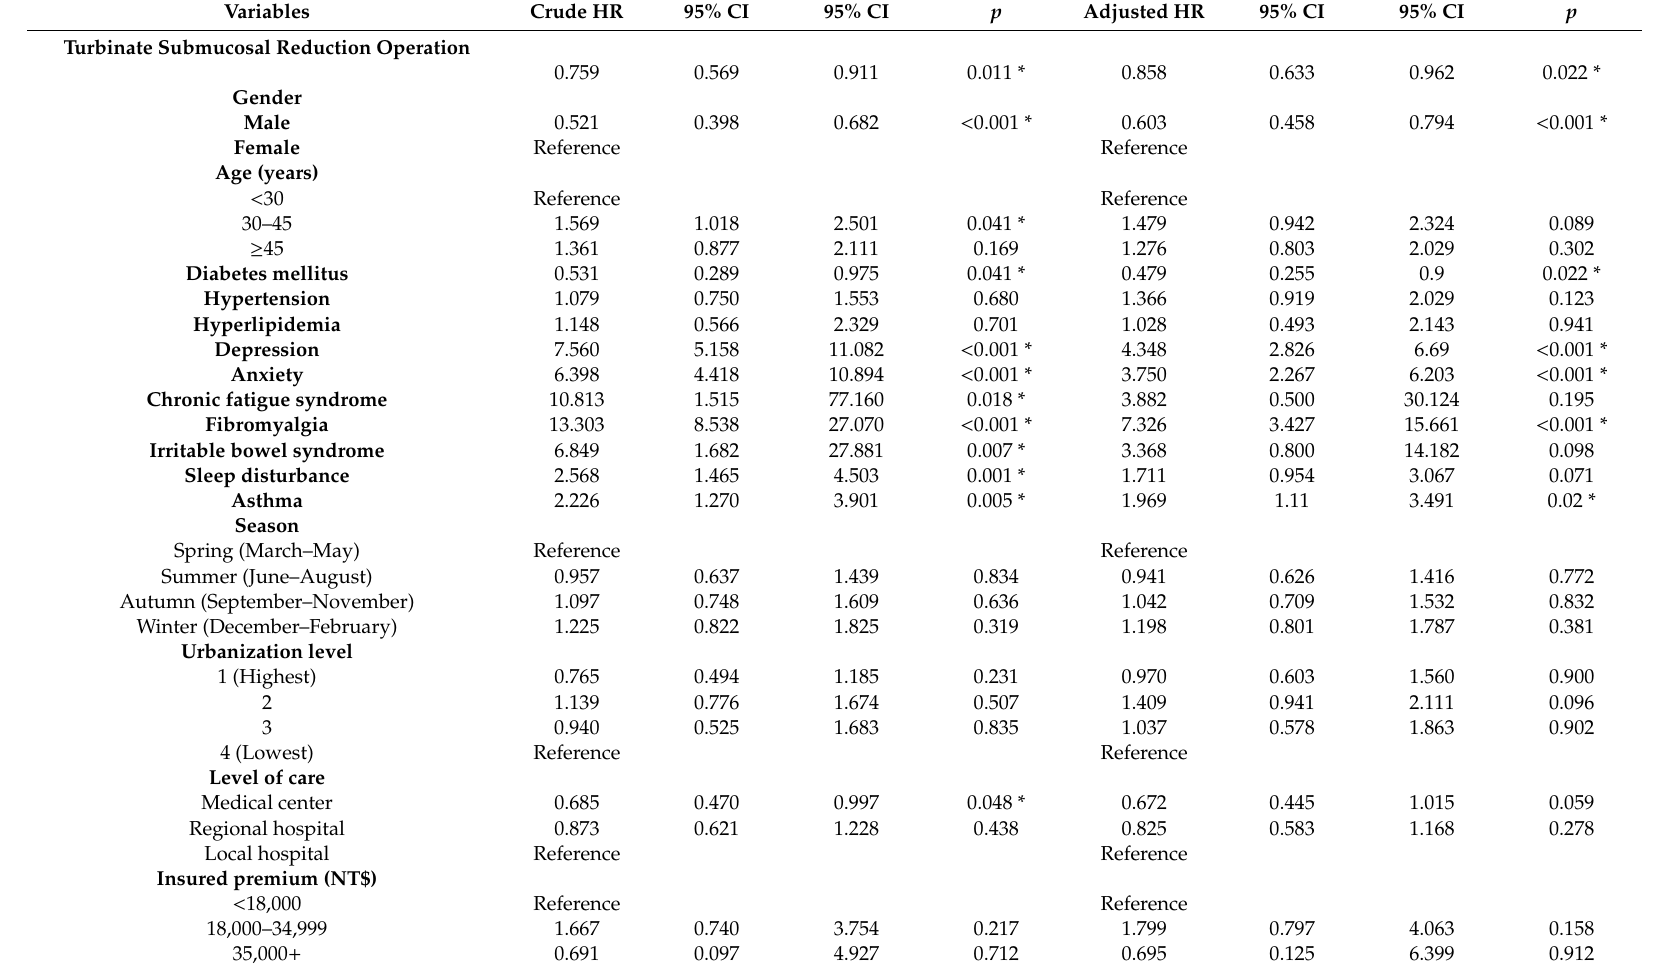
Table 2. Risk factors of migraine at the end of follow-up according to Cox